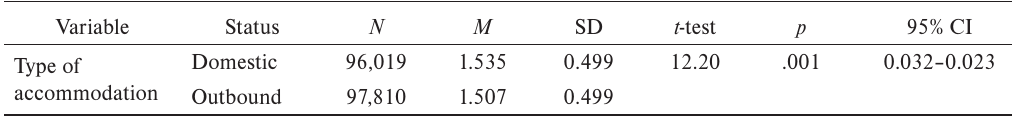
Differences in type of accommodation between domestic and outbound tourists Variable